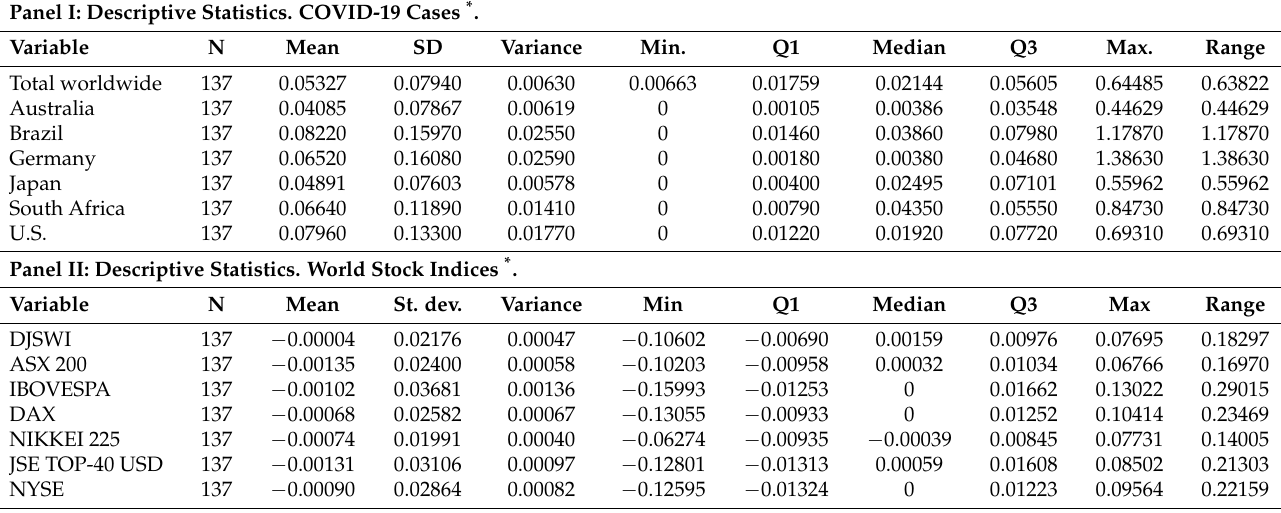
Table 2. Main univariate descriptive